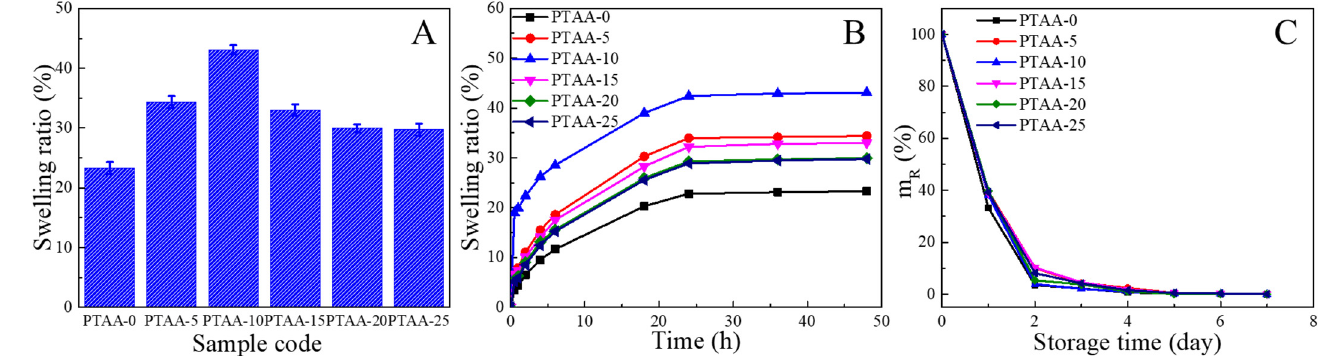
Figure 9. ( A ) Maximum water absorption ratio, ( B ) swelling kinetics, and ( C ) dewatering kinetics of various PVA/TA@ANFs/Ag hydrogels.